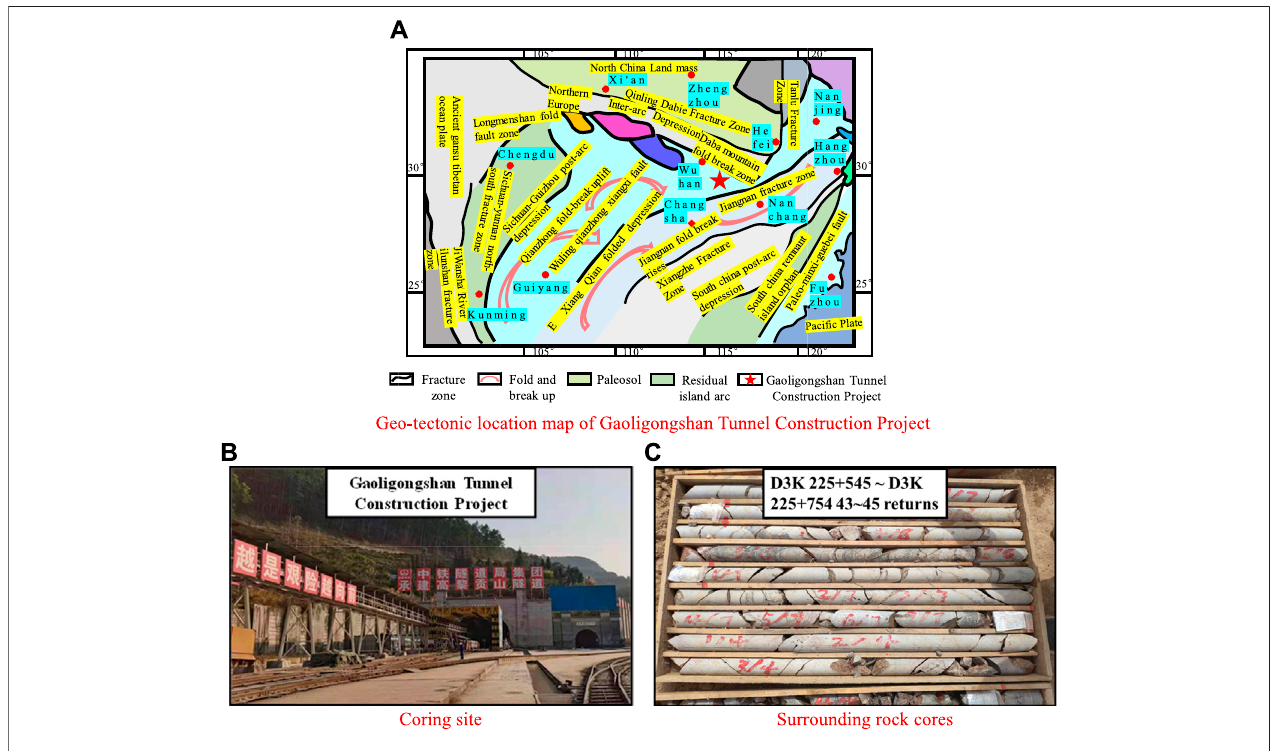
FIGURE 1 | Preparation process of granite specimens. (A) Geo-tectonic location map of Gaoligongshan Tunnel Construction Project. (B) Coring site. (C) Surrounding rock cores.